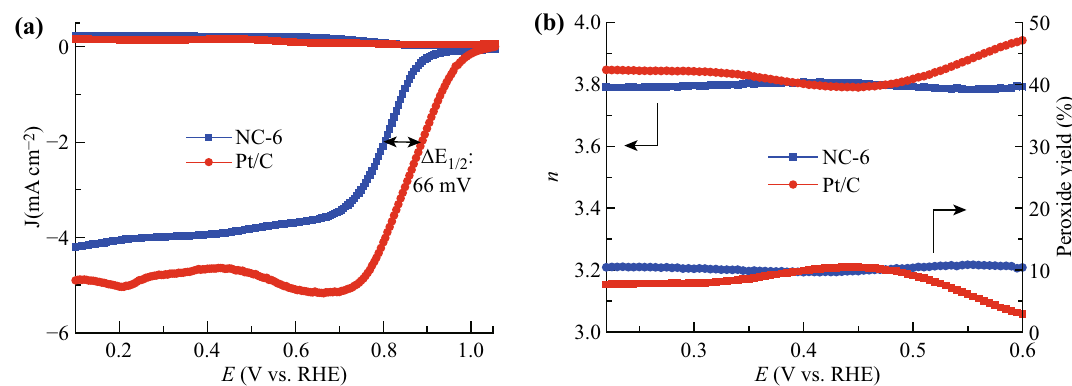
Fig. 7 a Ring-disk voltammograms of NC-6 and Pt/C at a scan rate of 10 mV s - 1 and 1600 rpm in O 2 -saturated 0.1 M KOH solution. b Peroxide yield and number of transferred electrons of NC-6 and Pt/C in O 2 -saturated 0.1 M KOH solution